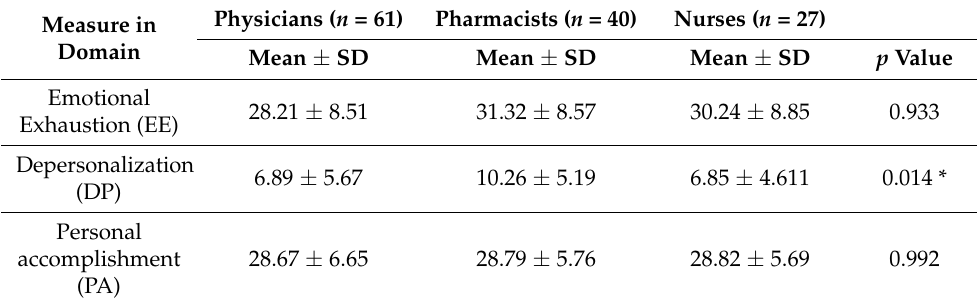
Table 3. Results from the Maslach Burnout index in the groups of physicians, pharmacists and nurses depending on the domain.